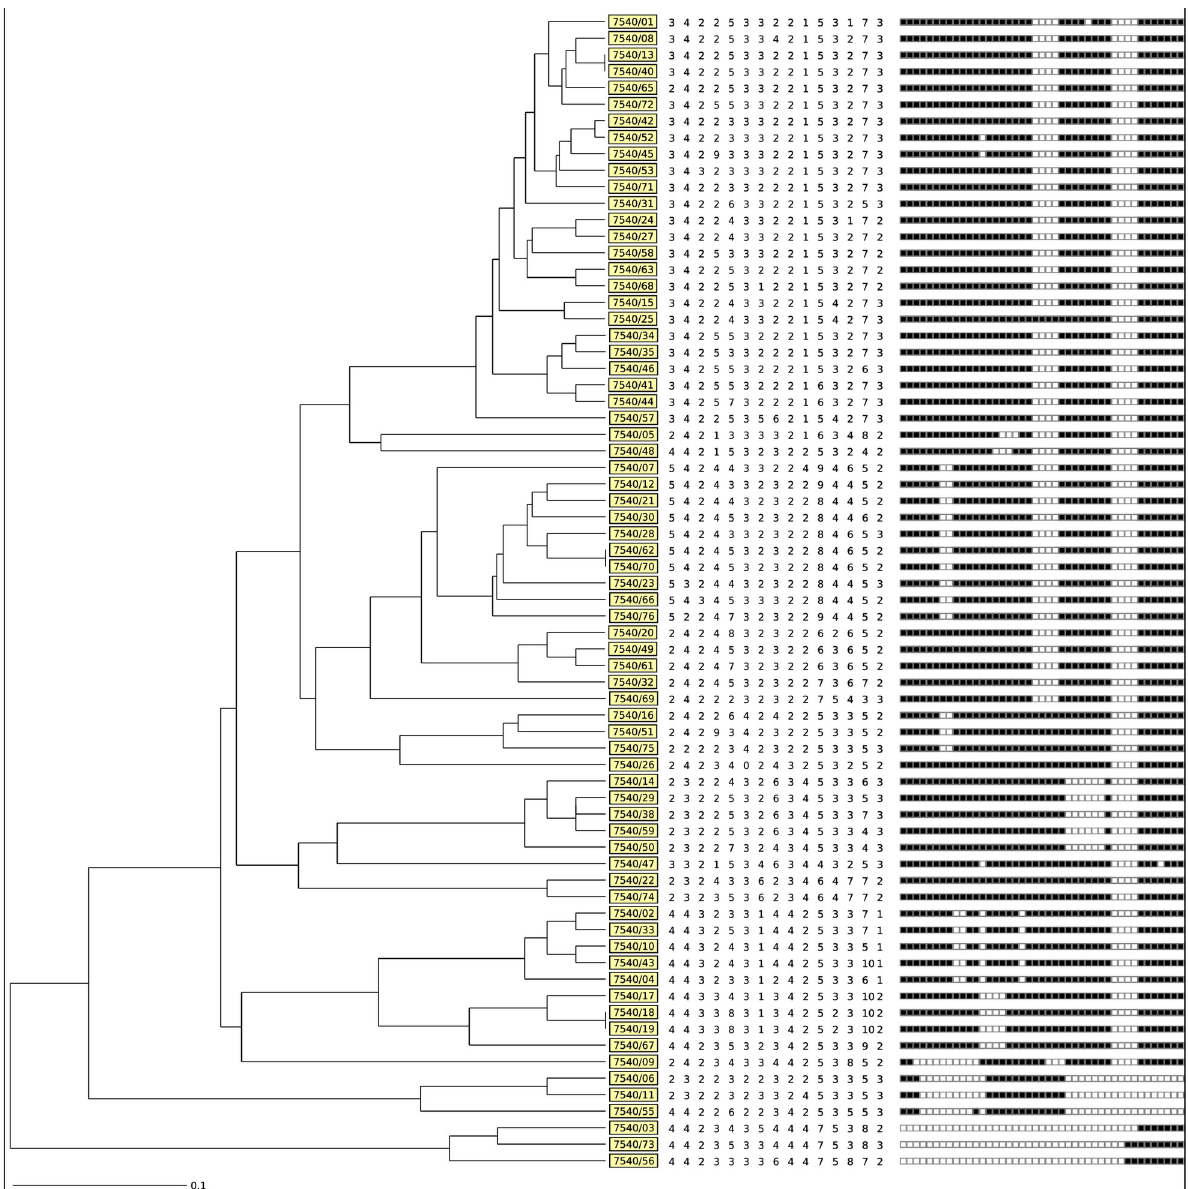
Fig 1. Phylogenetic tree based on spoligotyping and 15-locus MIRU-VNTR data of 70 MDR-MTB isolates from Grand Casablanca, Morocco. A dendrogram was generated based on the UPGMA algorithm using tools available from the MIRU-VNTR plus identification database . From left to right : (1) UPGMA dendrogram generated by the 15-locus MIRU-VNTR , (2) spoligotyping patterns , and (3) strain number (boxed)